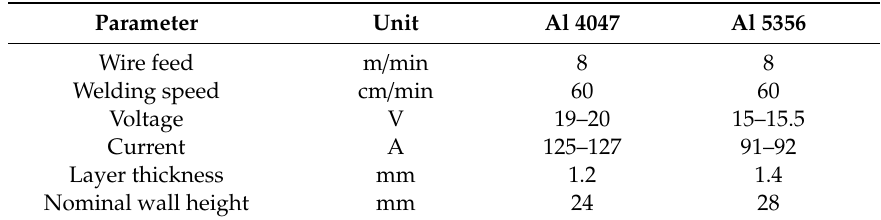
Table 2. Welding parameters used for sample